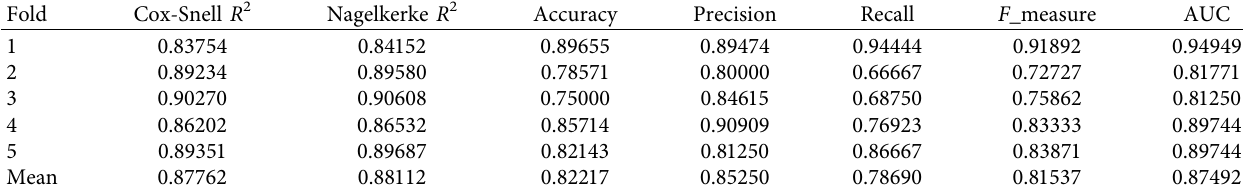
Figure 7: Te performance of the nomogram model. (a) ROC curve. (b) Calibration curve. (c) DCA curve. Table 3: 5-fold cross-validation assessing the prediction capability of our